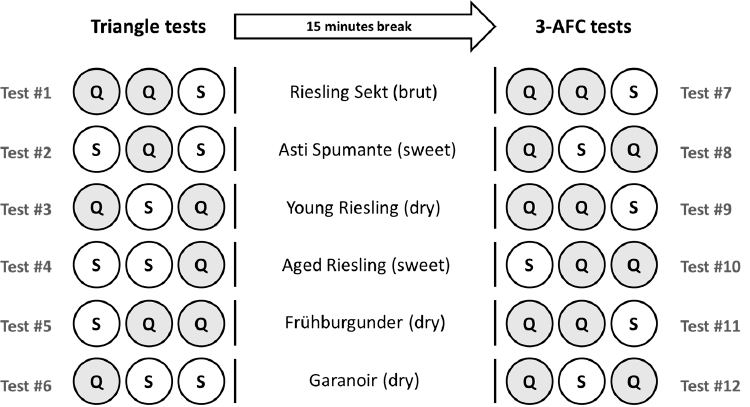
Figure 1. Design of the sensory analysis (with examples of the wine samples randomization: Q—quickly cooled samples, S—slowly cooled samples).